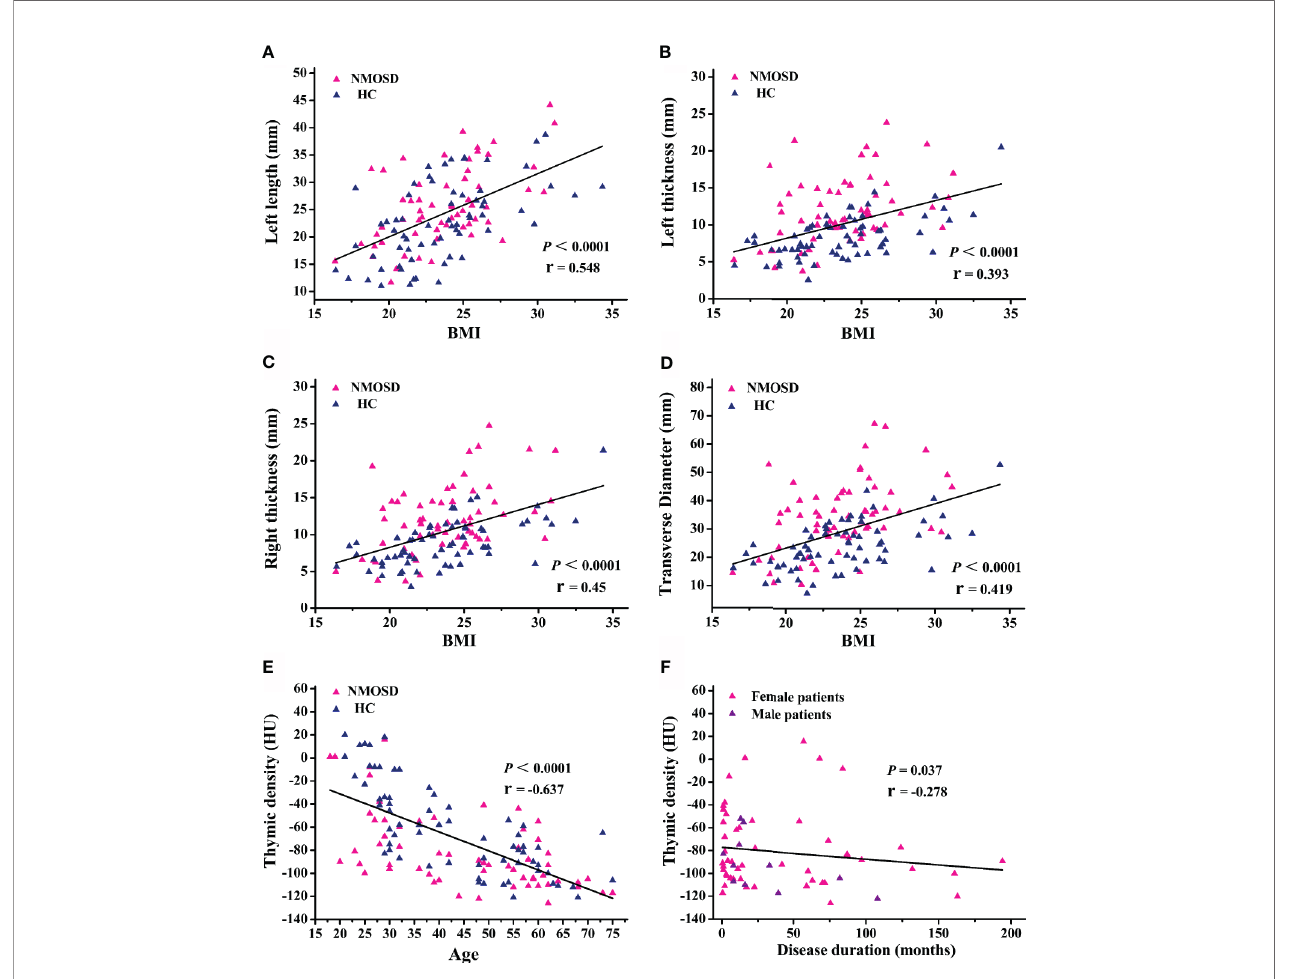
FIGURE 5 | Regression and partial correlation analysis of thymic predominant sides, density, and disease duration. (A – D) Scatter plots showing the correlation of thymic predominant sides with body mass index (BMI); r = partial correlation coef fi cient after controlling for age. (E) Scatter plots showing correlation of thymic density with age; r = partial correlation coef fi cient after controlling for BMI. (F) Association between thymic density and disease duration; r = partial correlation coef fi cient after for age and BMI. NMOSD, neuromyelitis optica spectrum disorder; HC, healthy